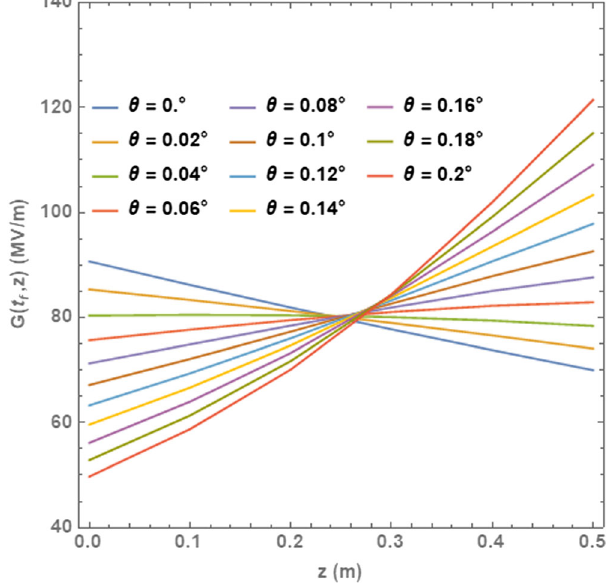
FIG. 12. The accelerating gradient after one filling time as a 0 . 5 m for a range of tapering angles θ . The function of z for L ffiffiffiffiffiffi s ¼ p P is chosen such that the average gradient h G i ¼ 80 MV = k